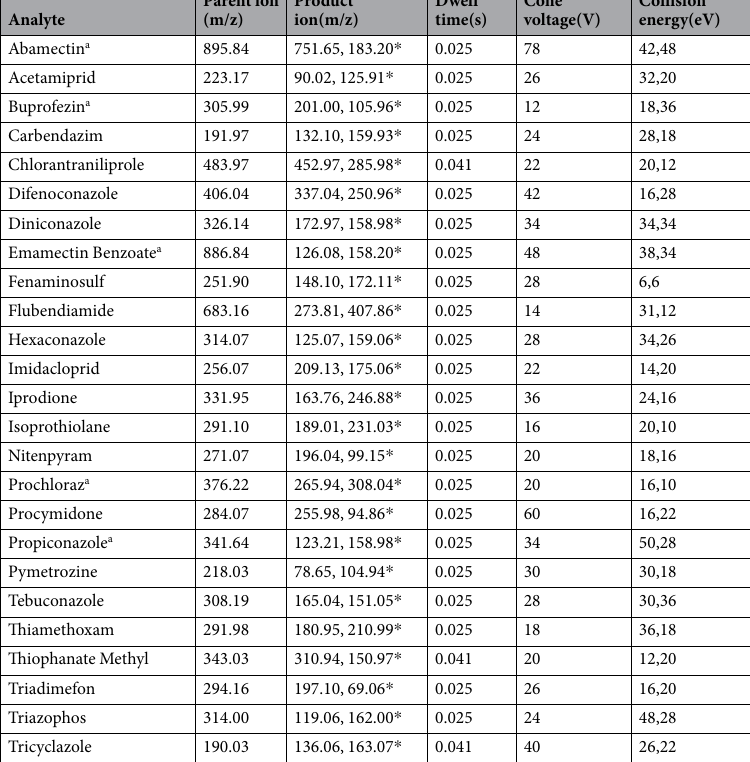
Table 1. LC -MS/MS parameters for 25 pesticides. * Ion for quantification. a Registered